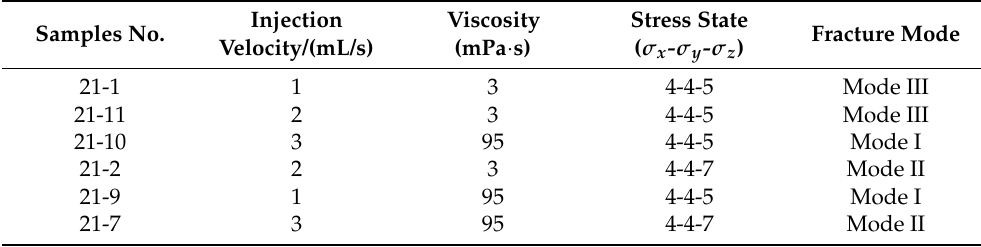
Table 2. Brazil-splitting test results.